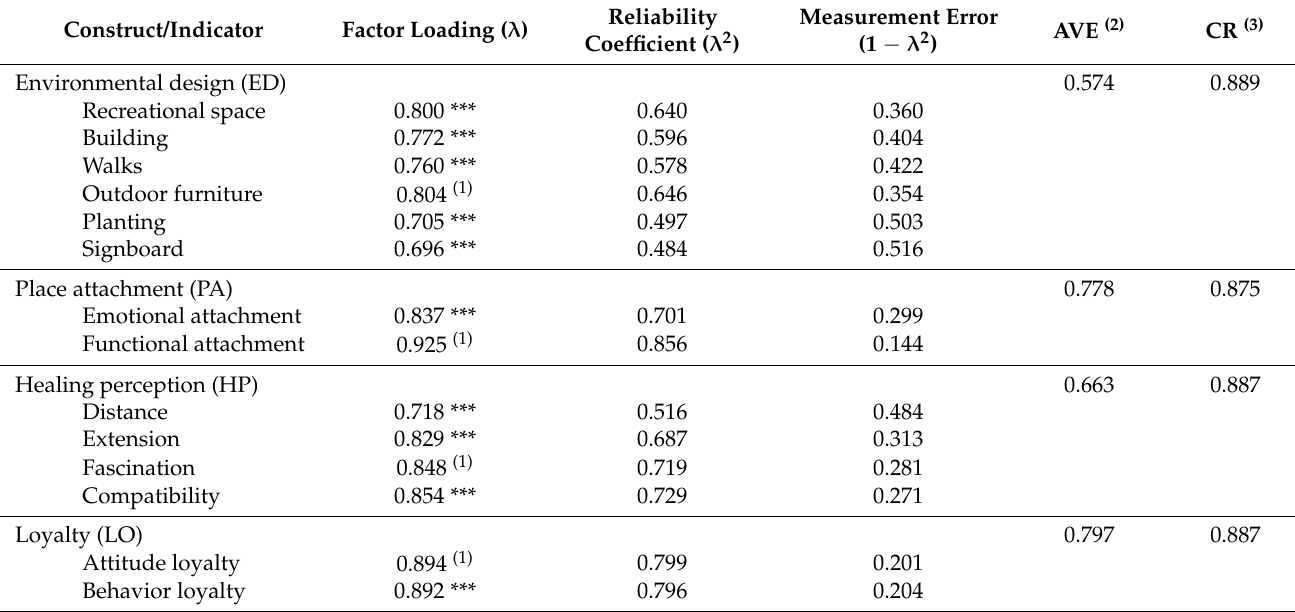
Table 3. Convergent validity of measurement